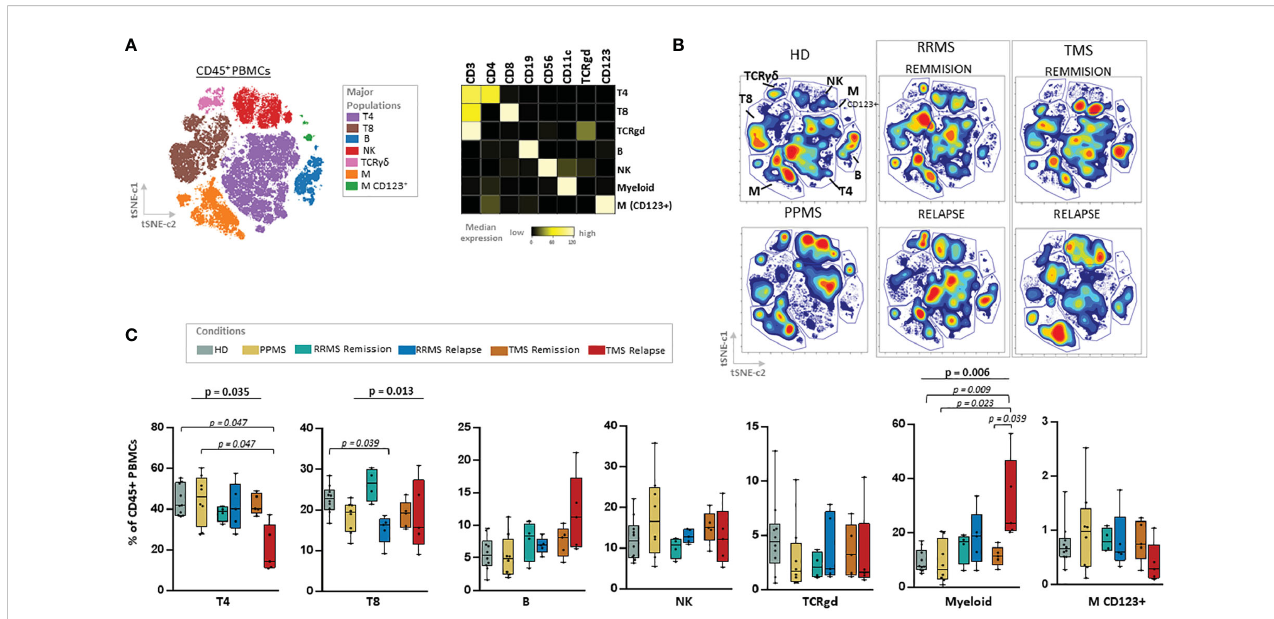
FIGURE 2 Major cell lineage subsets in peripheral blood of patients with MS during different disease stages and healthy donors. (A) Dimensionality reduction with t- SNE CUDA (t Distributed Stochastic Neighborhood Embedding) on all patients and healthy donors tSNE map (left) shows major immune cell subpopulations in the CD45+ compartment (named T4; CD4+ T cells, T8; CD8+ T cells, TCRgd T cells, NK cells, B cells, Myeloid and Dendritic cells). Major PBMC populations were annotated based on the expression of key lineage markers (CD3, CD8, CD19, CD56, CD11c, TCRgd, CD123). (B) t-SNE plots from one representative sample from each subgroup (PPMS, RRMS, TMS and HD). RRMS and TMS were further subdivided in those in remission (RRMS; n=4, TMS; n=5) and relapse (RRMS; n=5, TMS; n=5). (C) Box plots showing frequency (expressed as % of live singlet CD45+ cells) of each major immune cell subset in peripheral blood mononuclear cells of patient subgroup and healthy donors (n=10). Statistically signi fi cant changes are shown in the image (p < 0.05 was considered signi fi cant, non-parametric Kruskal Wallis test with correction for multiple comparisons (FDR) was applied). PPMS, Primary Progressive Multiple Sclerosis; RRMS, Relapsing Remitting Multiple Sclerosis; Rem, Remission; Rel, Relapse, HD, Healthy donors; TMS, Tumefactive Multiple Sclerosis; T4; CD4+ T cells, T8; CD8+ T cells, M, Myeloid cells; D, Dendritic cells; NK, natural killer cells; t-SNE, t-distributed stochastic neighbor embedding; FlowSOM, Flow Self-Organizing Map; FDR, false discovery